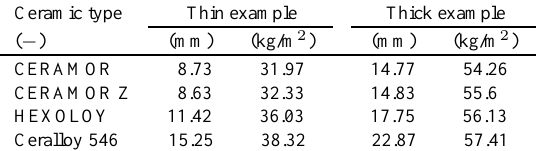
Fig. 1. Hybrid armor example. Table 1 Thickness and area density of ceramics